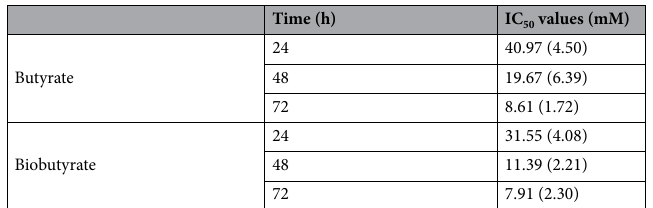
Table 1. IC 50 values of biobutyrate and butyrate for HT29 cell. The administration time was indicated in the Table. The IC 50 values represent the mean of at least 3 independent experiments (SD). The Excel program was applied to determine mean and SD. Following the analysis by GraphPad Prism 7, the nonlinear regression was used to calculate IC 50 . The difference between biobutyrate-based and butyrate-based IC 50 at 24, 48, and 72 h were insignificant ( p = 0.1916, 0.1909, and 0.7464,